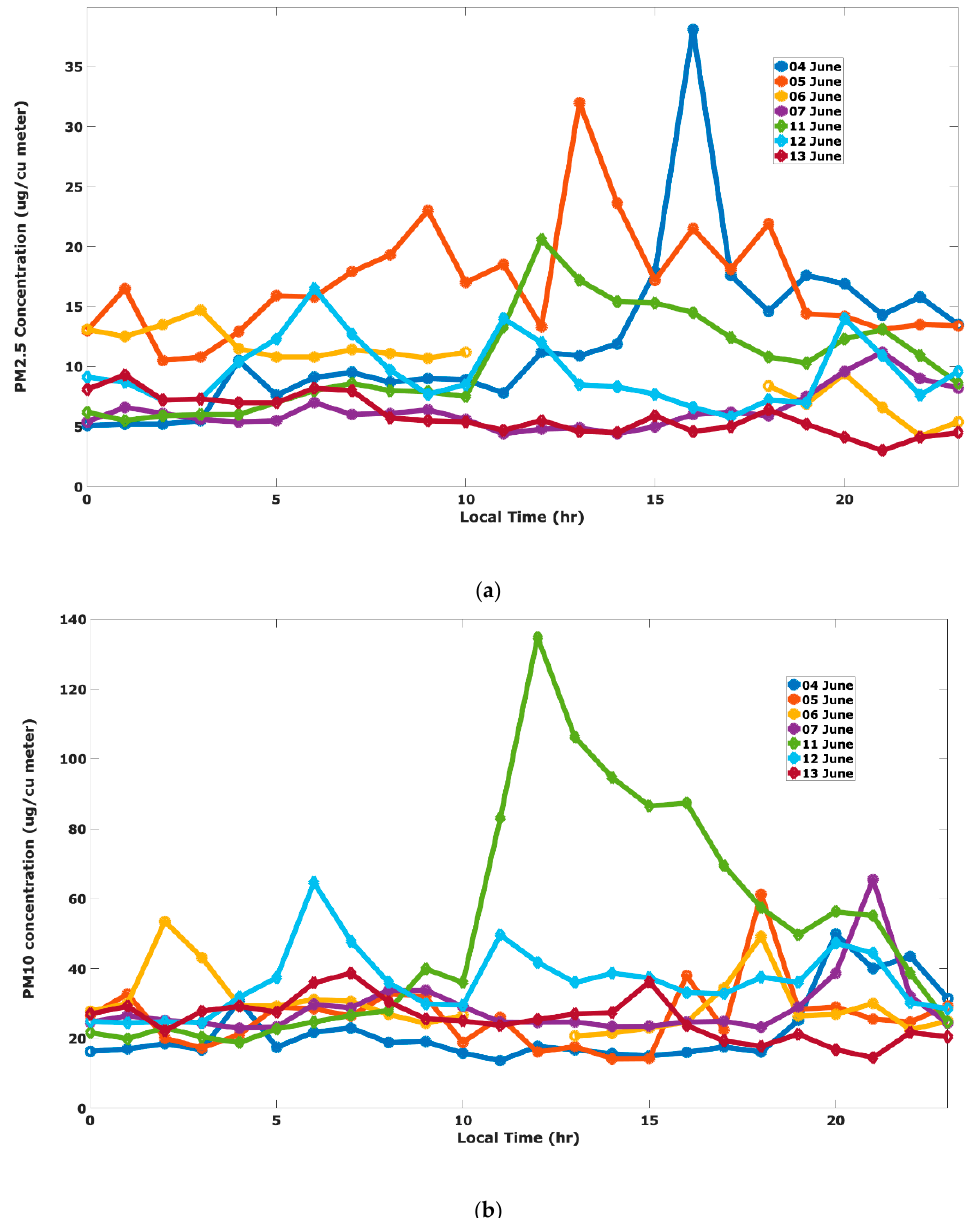
Figure 5. ( a ) PM 2.5 concentrations and ( b ) PM 10 concentrations during the high and low ozone episodes. Figure 5. ( a ) PM2.5 concentrations and ( b ) PM10 concentrations during the high and low ozone Data obtained from TCEQ CAMS episodes. Data obtained from TCEQ CAMS 12.